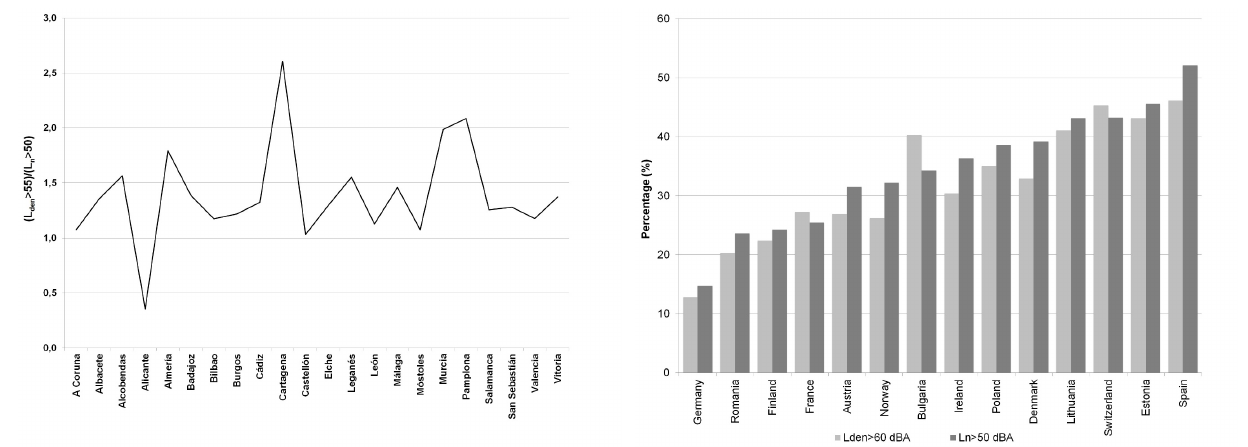
Figure 3: The ( L den > 55)/( L n > 50) ratio for all Spanish agglomera- tions.